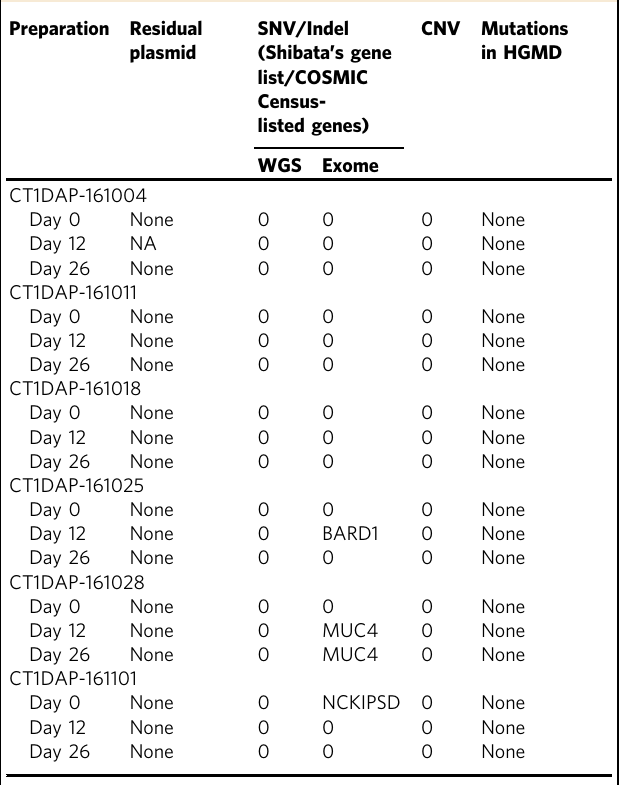
Table 2 Summary of the genome analysis. Preparation Residual